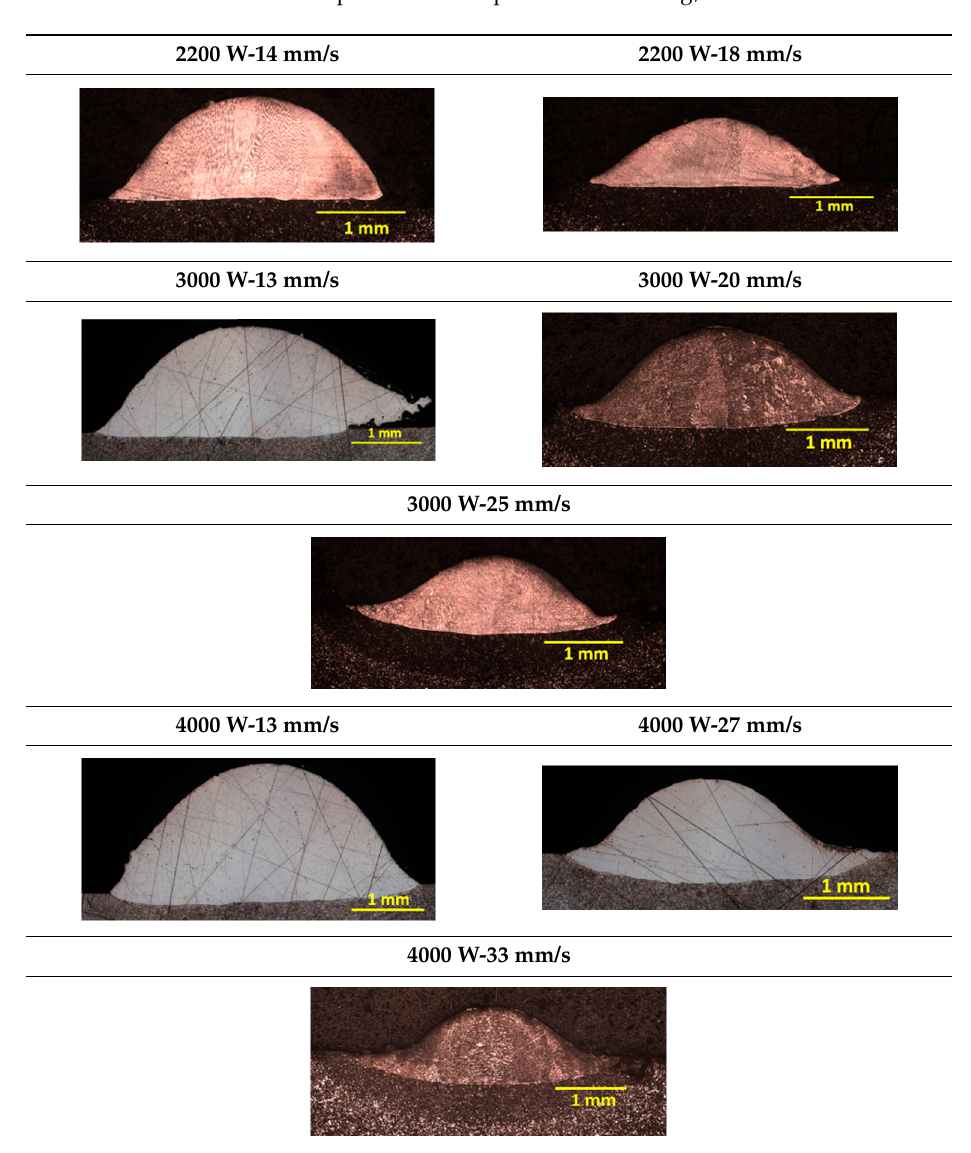
Table 5. Experiments with powder flow of 31 g/min.